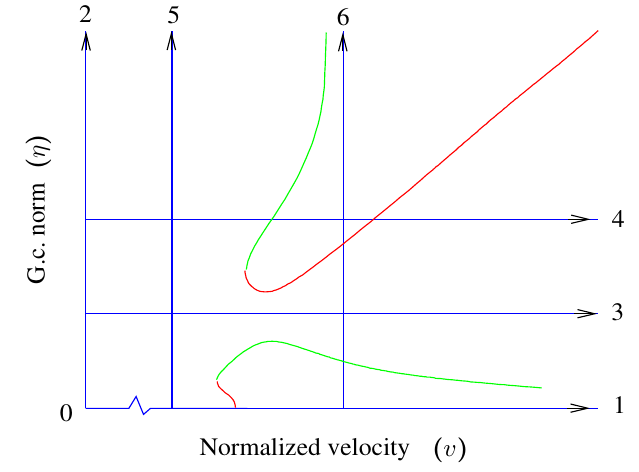
Figure 3. Grid (blue) for finding limit cycles. Green means stable, red means